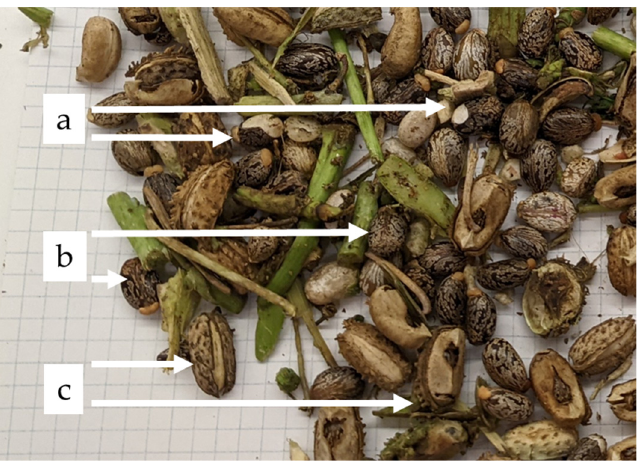
Figure 5. Sample of seeds collected within the tank of the combine harvester and classified as: ( a ) damaged seeds; ( b ) undamaged seeds; ( c ) unopened seeds.